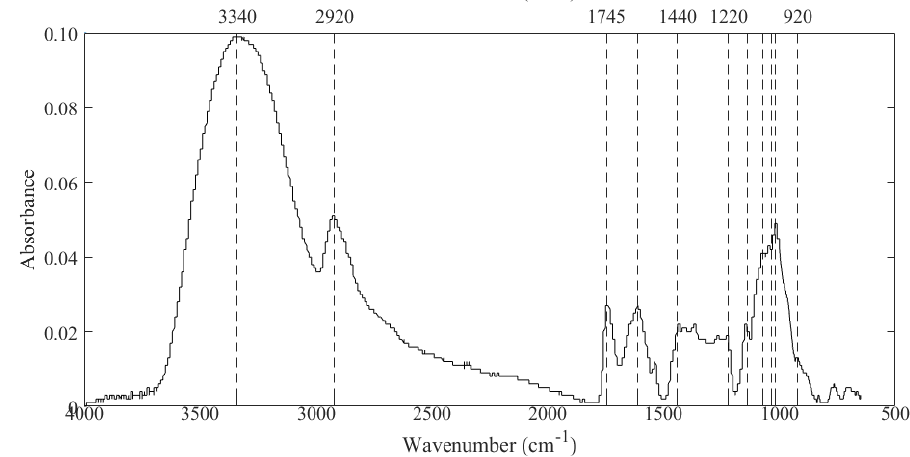
Figure 3. FT-IR spectrum of Haden mango peel